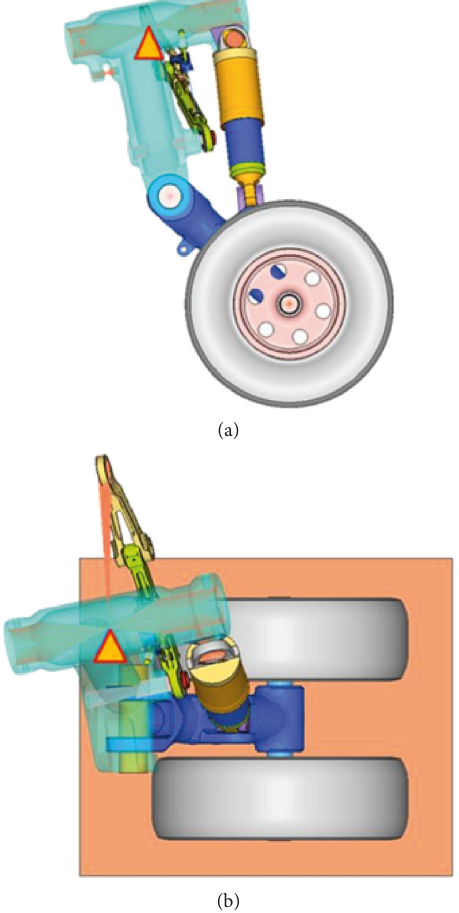
Figure 16: Landing gear model: (a) side and (b) top views.